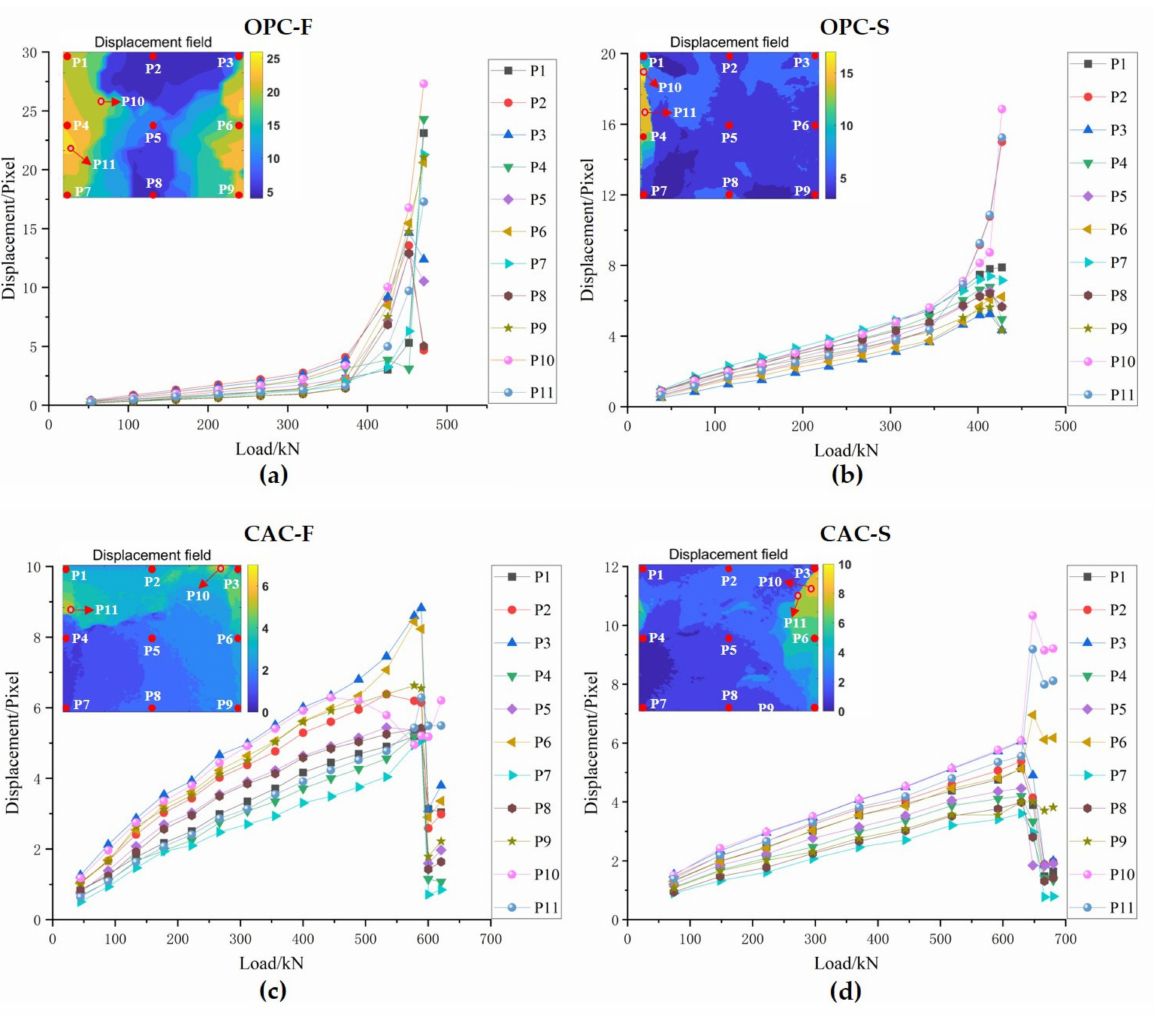
Figure 6. Displacement–loading curves of 11 typical points (Pi (i = 1,2, . . . ,9) were four corners, middle points of four edges and the whole surface; P10 and P11 were two locations with larger displacement values) selected on the front surface of ( a ) OPC-F, ( b ) OPC-S, ( c ) CAC-F and ( d )